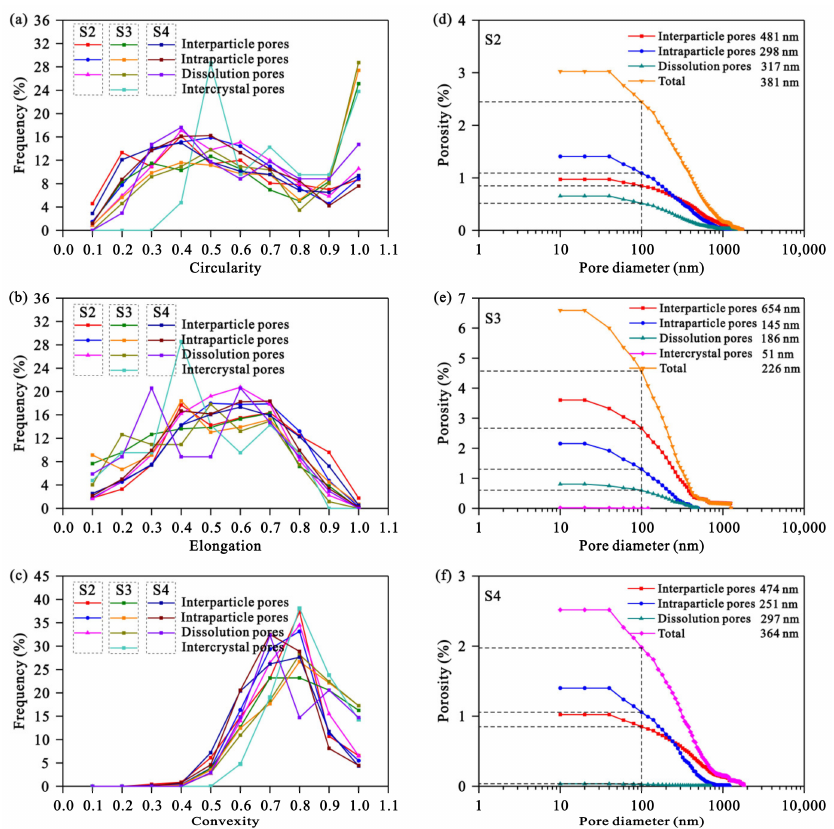
Figure 6. Pore morphology parameters and pore size distributions in felsic-rich shales: ( a ) Circularity; ( b ) Elongation; ( c ) Convexity; ( d ) Pore size distribution of S2; ( e ) Pore size distribution of S3; ( f ) Pore size distribution of S4.